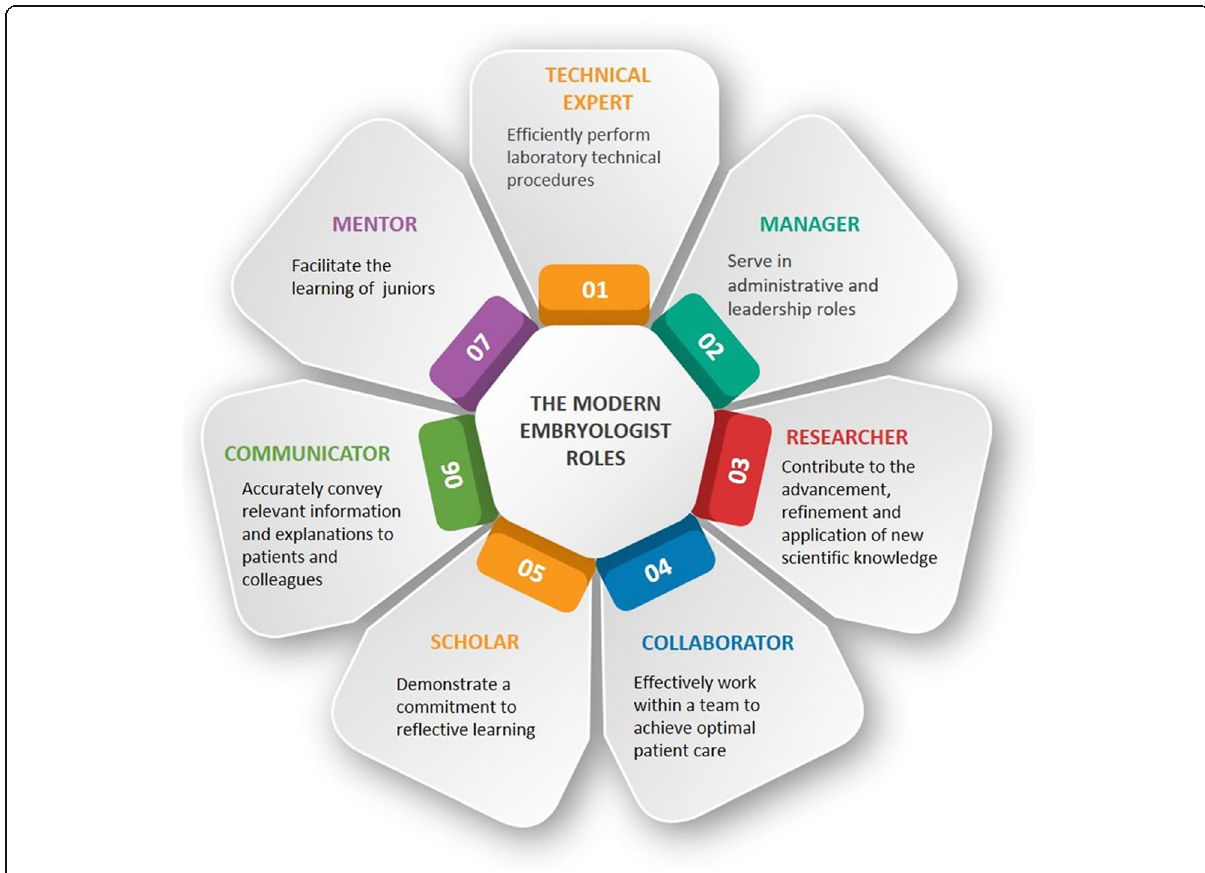
Fig. 1 Diagram of the seven key roles of the successful